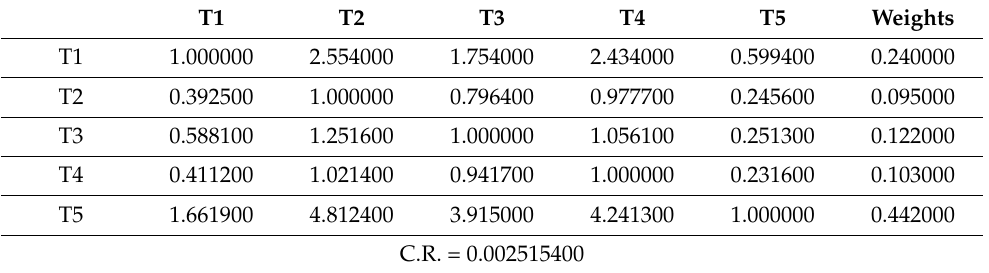
Table 7. Defuzzified pair-wise comparison matrix.